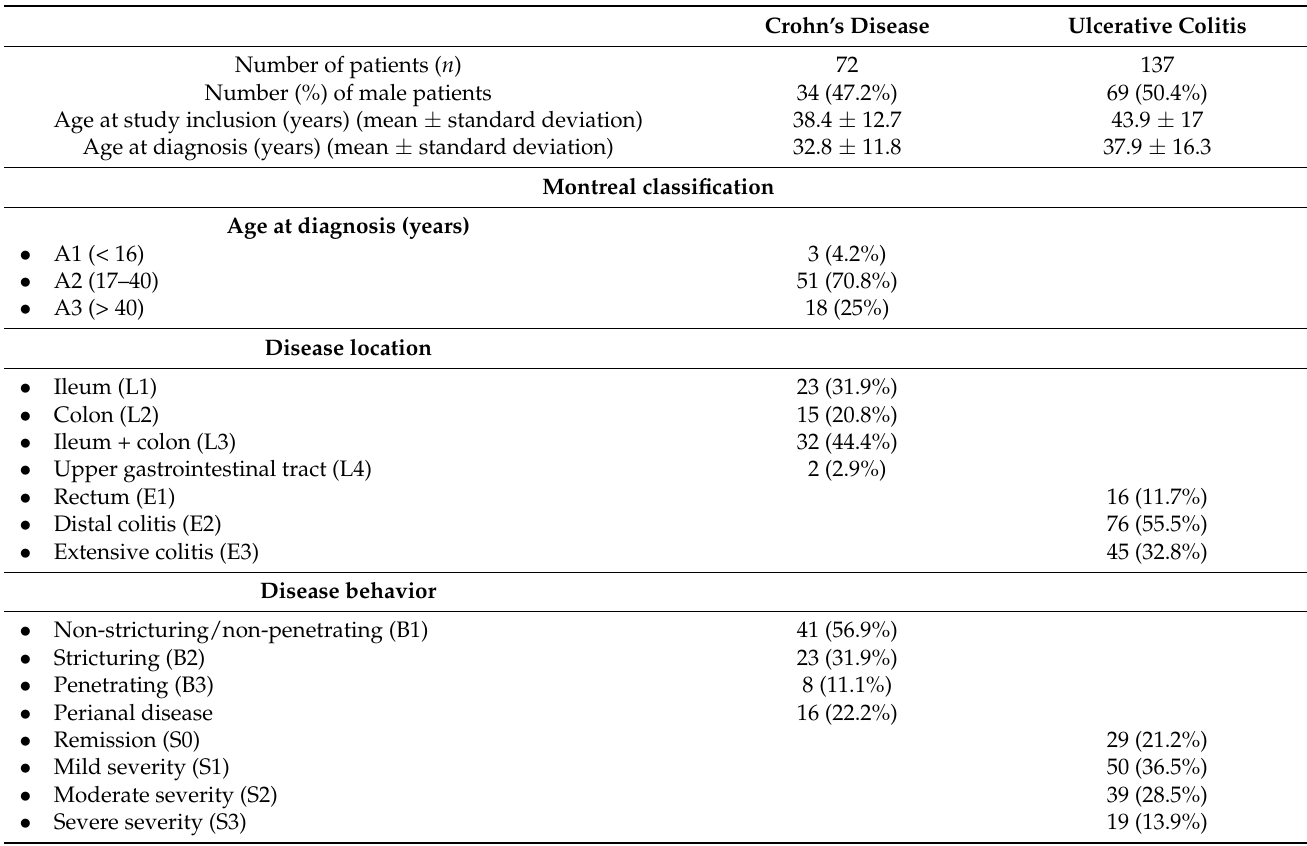
Table 1. Clinical characteristics of the studied patients.